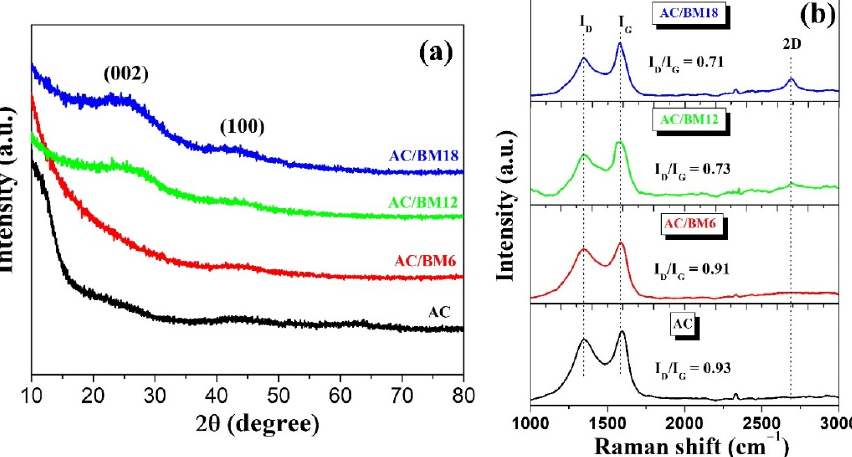
Figure 2. ( a ) The XRD pattern and ( b ) Raman spectra of AC, AC/BM6, AC/BM12 and AC/BM18.